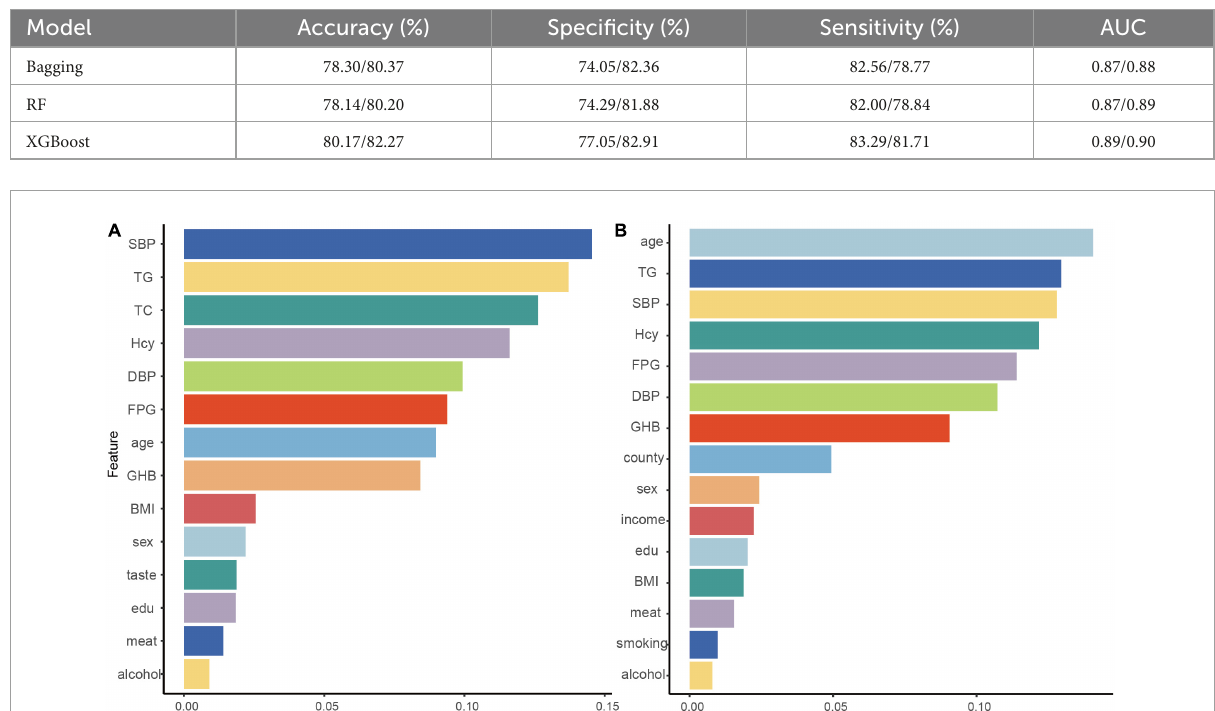
TABLE 5 Performance evaluation of the three classifiers on the testing set (ACR/MCR outcomes).